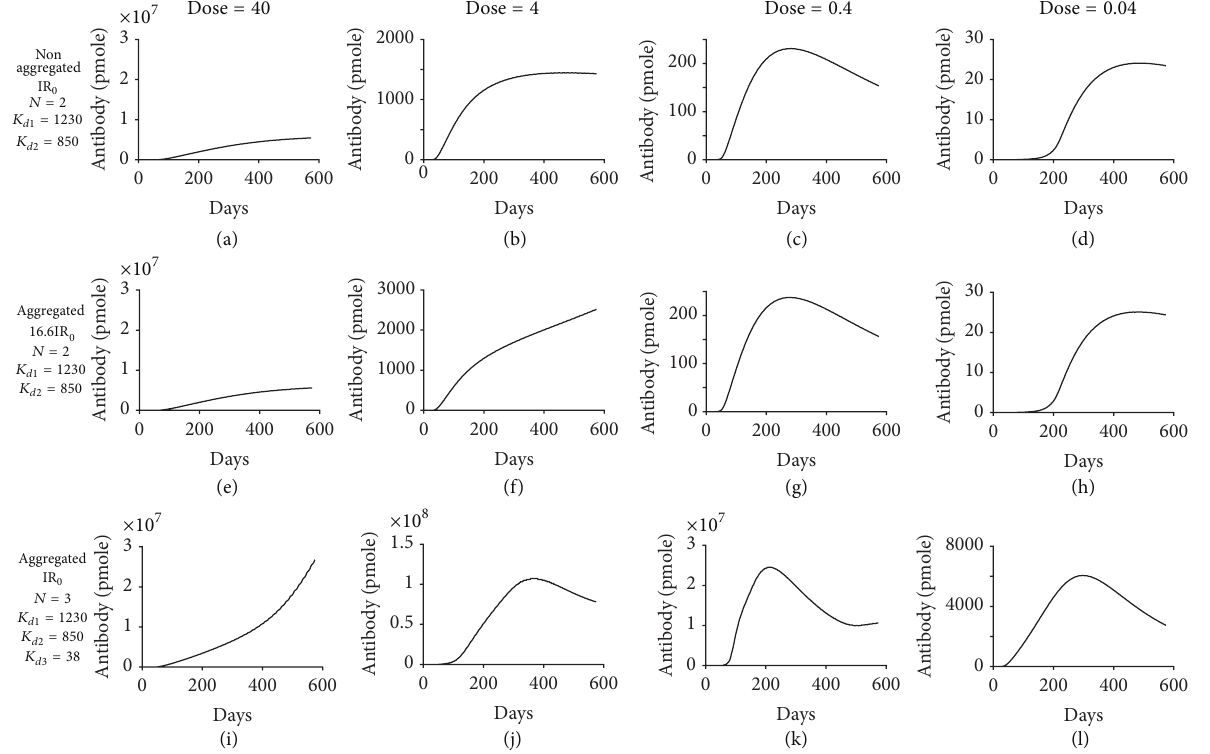
Figure 8: Aggregation could contribute to immunogenicity by inducing the presentation of high affinity epitopes that may not be present in nonaggregated TPP under a variety of drug doses. Simulated ADA production is shown for the same conditions as in Figure 7 for biweekly administered dose of 40 mg ((a), (e), and (i)), 4mg ((b), (f), and (j)), 0.4 mg ((c), (g), and (k)), and 0.04 mg ((d), (h), and (l)). ADA production has the same definition as in Figure